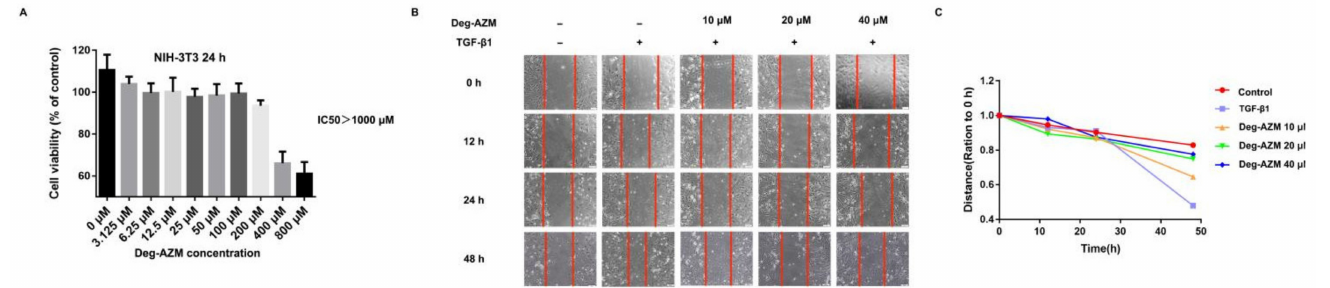
Figure 4. Deglycosylated azithomycin inhibits TGF- β 1-induced fibroblast proliferation and migration. ( A , B ) MTT assays of NIH3T3 cells. Cells were exposed to the indicated doses of deglycosylated azithromycin for 24 h, IC 50 = 1078 µ M, ( n = 3 per group). ( C ) Wound healing assays of cells co-cultured with TGF- β 1 (5 ng/mL) and deglycosylated azithromycin (10, 20 and 40 µ M). The wound closure was photographed at 0, 12, 24 and 48 h post-scratching. Data are presented as the means ± SD ( n = 3). Comparisons between groups were achieved using one-way analysis of variance